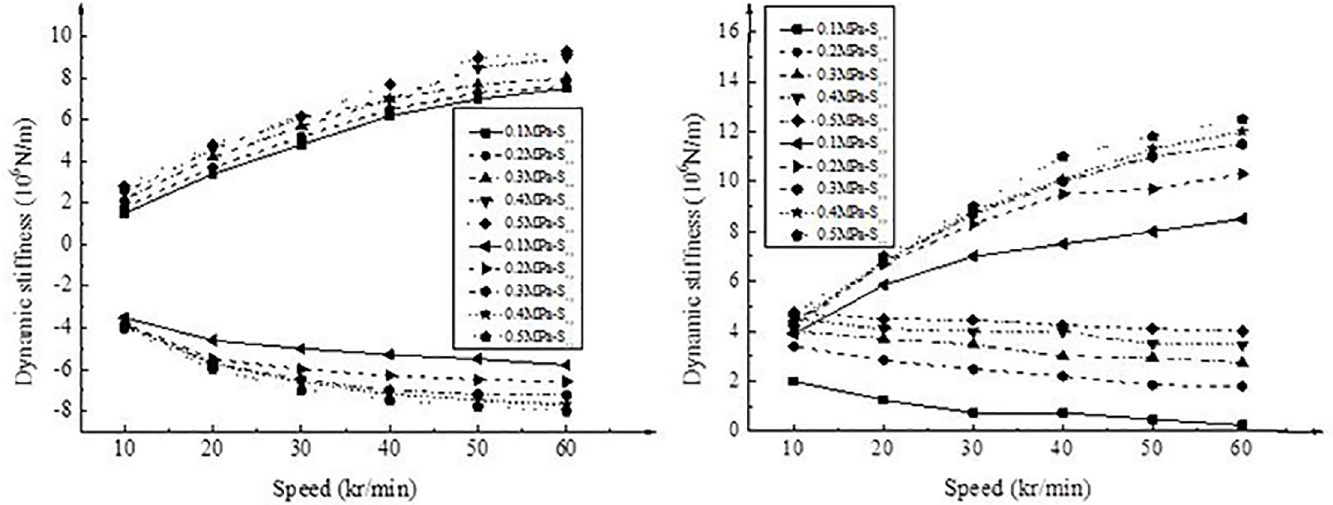
Fig 6. Distribution and changes of dynamic stiffness for gas bearing-rotor system: (a) S xx and S xy ; (b) S yx and S yy .